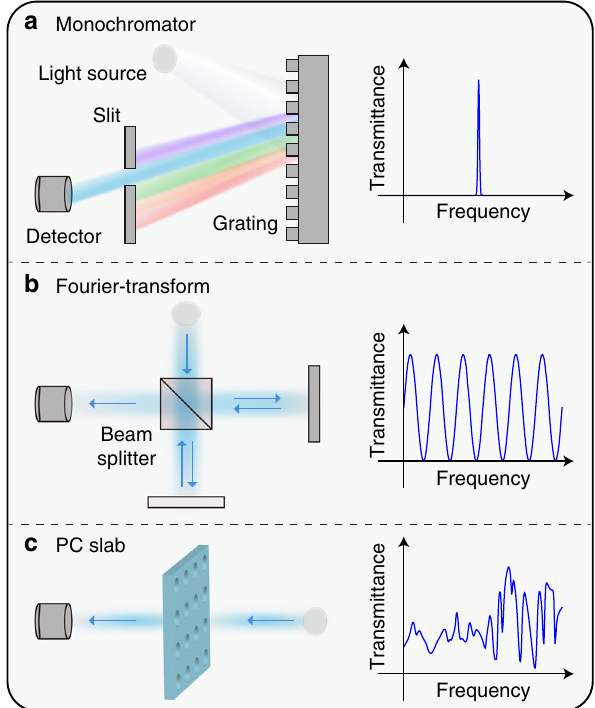
Fig. 1 Different spectrometers and their spectral responses. a The spectral responsivity of grating or microcavity spectrometers has a single sharp peak. The spectrum is measured by point-wise sampling. b The spectral responsivity of a Fourier-transform spectrometer is a sinusoidal function. The period varies to perform sampling based on Fourier basis. c Photonic- crystal (PC) slabs create complex and variable spectral responsivity depending on the structures. They randomly sample the incident